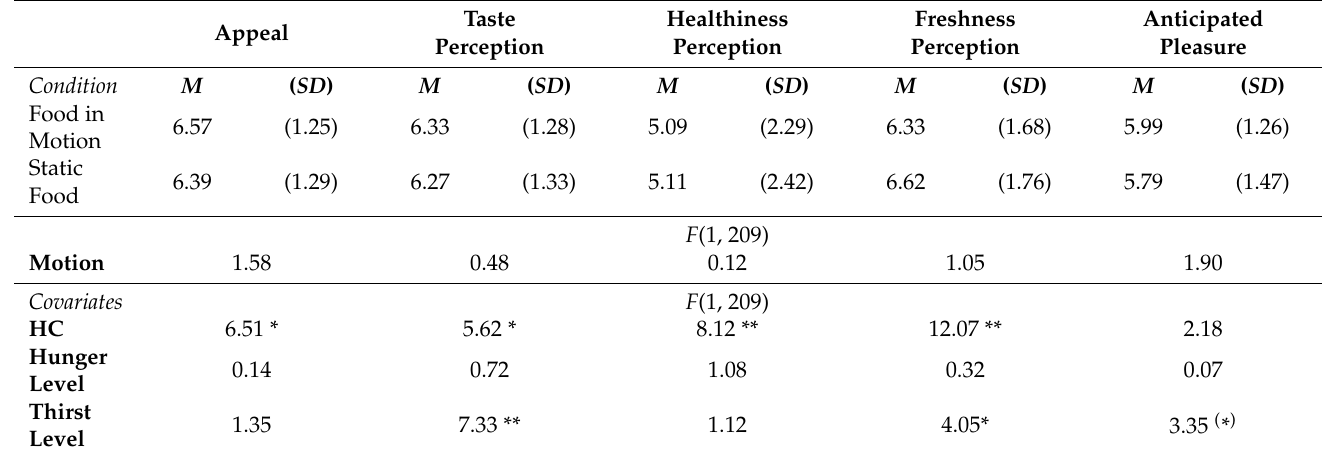
Table 7. Descriptives and multilevel results from the main effects in Study